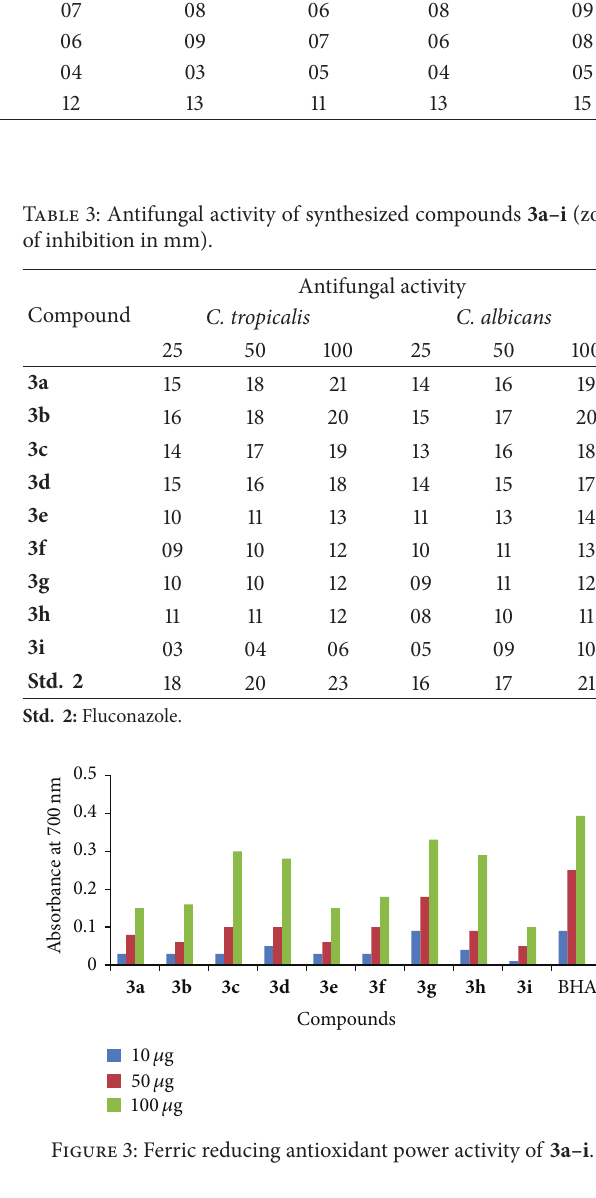
gram-positive bacteria Staphylococcus aureus ( S. aureus ) at 25 𝜇 g/mL, 50 𝜇 g/mL, and 100 𝜇 g/mL concentrations, respec- tively. Gentamycin was used as standard. The zones of inhi- bitions were measured in mm for each concentration.